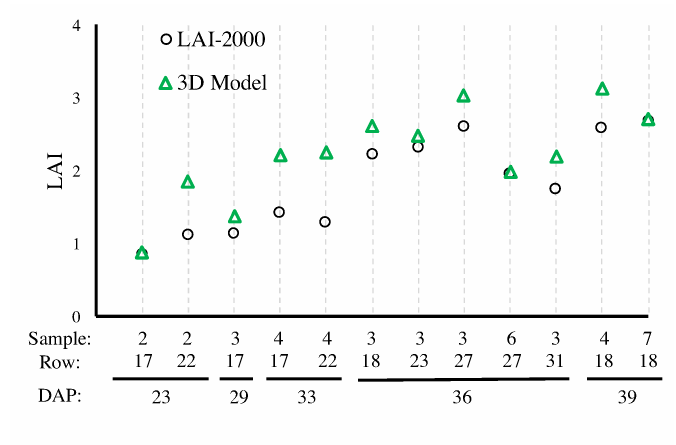
Figure 8. Comparison of LAIs obtained by LAI-2000 and Vinobot using 3D reconstruction of the leaves. The horizontal axis shows the number of samples collected per row; the row number from Figure 5; and the days after planting (DAP) for each observation.